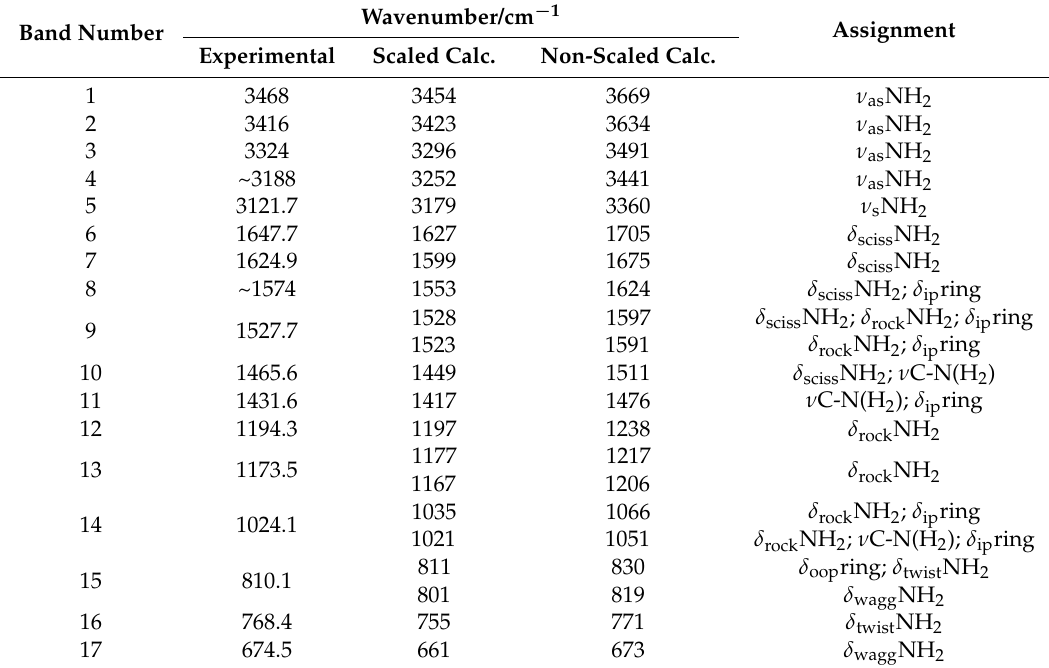
Table 1. Band assignments in the experimental ATR-IR spectrum of crystalline melamine. Band numbers correspond to those presented in Figure